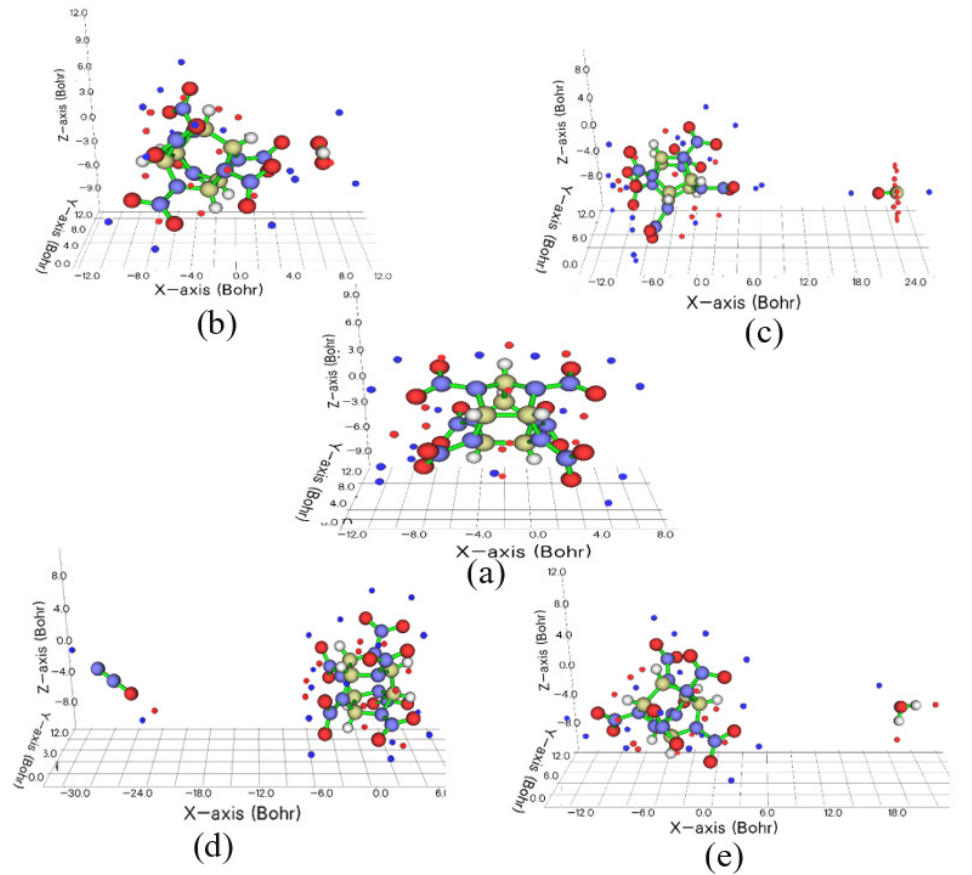
Figure 3. The surface minima and maxima: ( a ) CL-20, ( b ) CL-20/H 2 O 2 , ( c ) CL-20/CO 2 , ( d ) CL-20/N 2 O, and ( e ) CL-20/H 2 O. Red and blue spheres represent the position of maxima and minima, respec- tively.